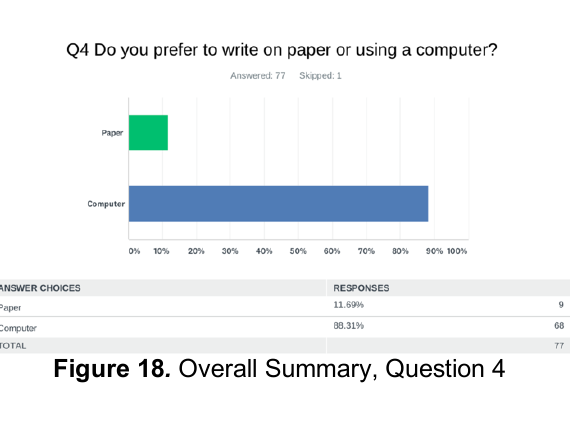
Figure 17 . Overall Summary, Question 3